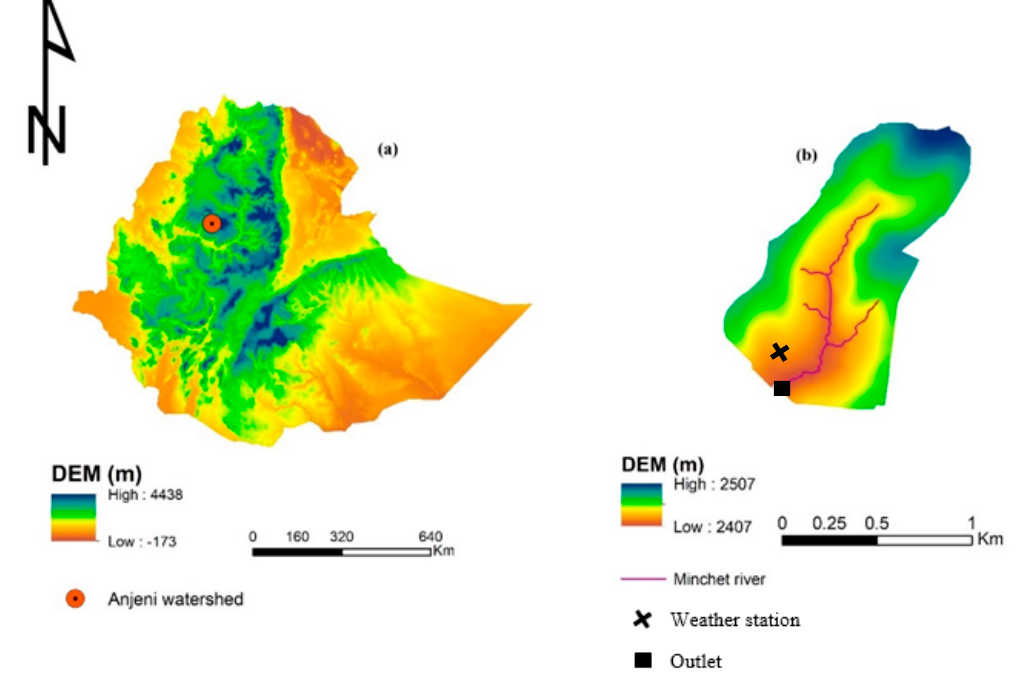
Figure 1. Location of the study site in the Ethiopian highlands; Digital Elevation Model (DEM) maps of Ethiopia ( a ) and the DEM map of Anjeni watershed ( b ). The red circle with a black outline indicates the location of the Anjeni Map in Ethiopia.